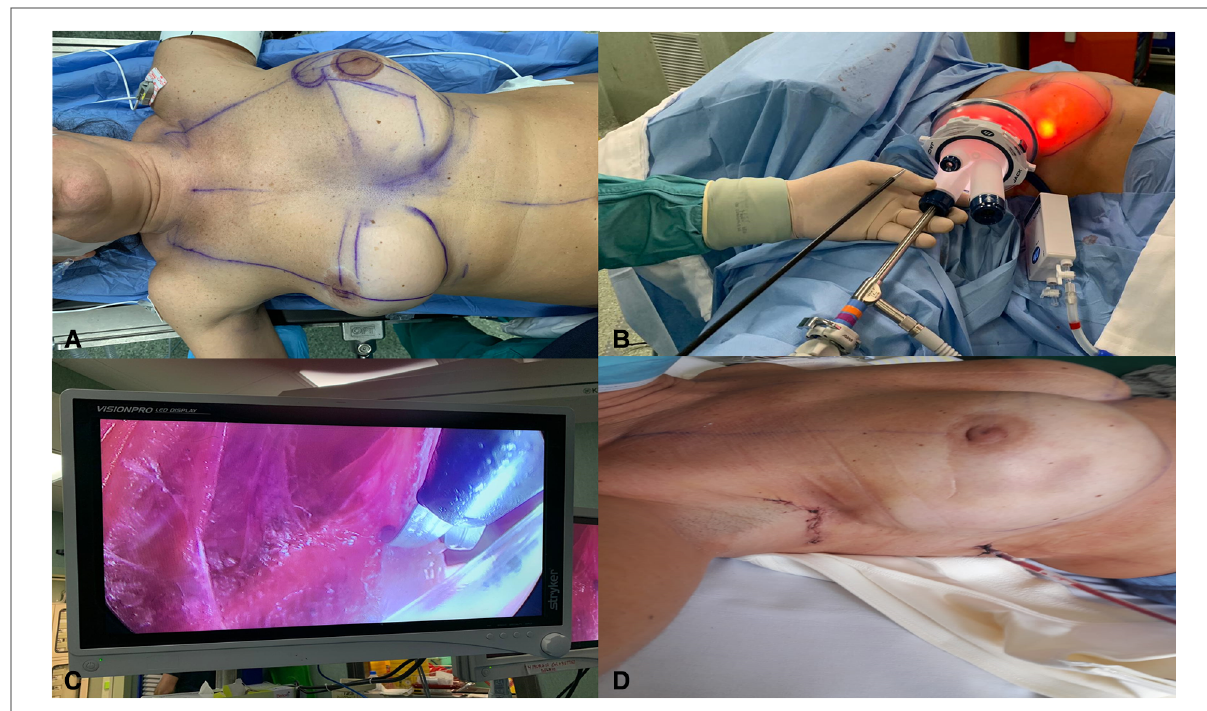
FIGURE 2 ( A ) Patient positioned supine on the operating table with the arms extended and held in place of 90° at the height of the axilla. ( B ) Axillary incision and introduction of a single endoscopic port for endosurgery. ( C ) Endoscopic-guided circumferential capsulotomy. ( D ) Immediate postoperative